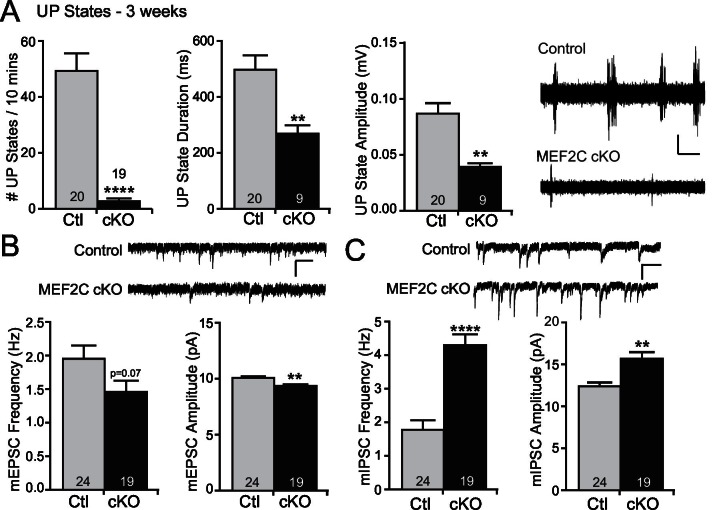
Increased cortical inhibition in Mef2c cKO mice.(A) UP states in 3-week old Mef2c cKO mice. Mef2c cKO mice have fewer spontaneous UP states than control mice. Additionally, the duration and amplitude of each spontaneous UP state was significantly reduced in the Mef2c cKO mice. Representative recordings from control and Mef2c cKO organotypic slices. Scale bar = 50 µV/1 s. (B) Mef2c cKO mice have reduced mEPSC frequency and amplitude in cortical layer 2/3 pyramidal neurons from 3-week old mice. Scale bar = 200 ms/10 pA. (C) Mef2c cKO mice have increased mIPSC frequency and amplitude in cortical layer 2/3 pyramidal neurons from 3-week old mice. Scale bar = 200 ms/10 pA. Data are represented as mean ± SEM. Statistical significance was determined by unpaired t-test using GraphPad Prism. *p<0.05, **p<0.01, ****p<0.0001. Numbers of slices/neurons (n) are reported in each bar for respective experiment.